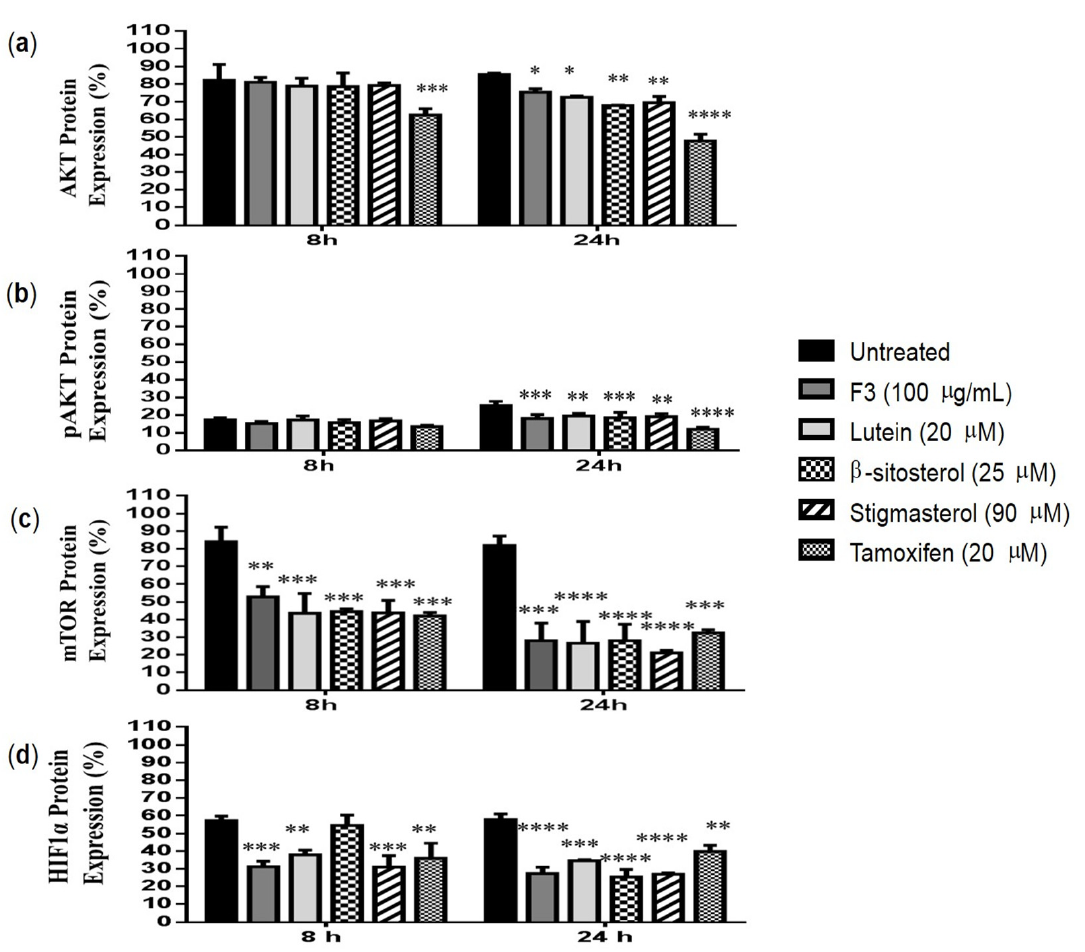
Figure 7. Expression of glycolysis regulatory protein. MDA-MB-231 cells were treated with IC 50 concentrations of F3, lutein, β -sitosterol, and stigmasterol for 8 and 24 h. Protein expression of ( a ) AKT, ( b ) pAKT, ( c ) mTOR, and ( d ) HIF1 α were measured using flow cytometry. Data are presented as the mean ± SD ( n = 3). * p < 0.05; ** p < 0.01; *** p < 0.001; **** p < 0.0001 .